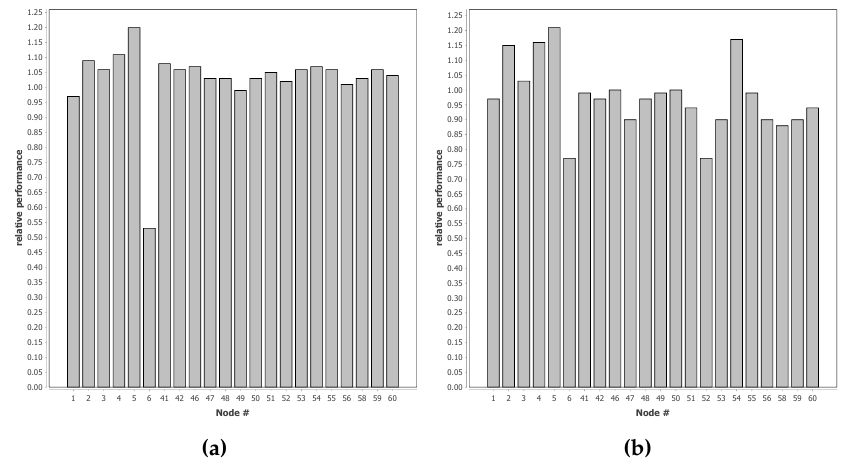
Figure 7. Relative performance for QUEST classifiers compared to fully supervised trained classifiers; ( a ) Relative performance for AAV vehicles; ( b ) Relative performance for DW